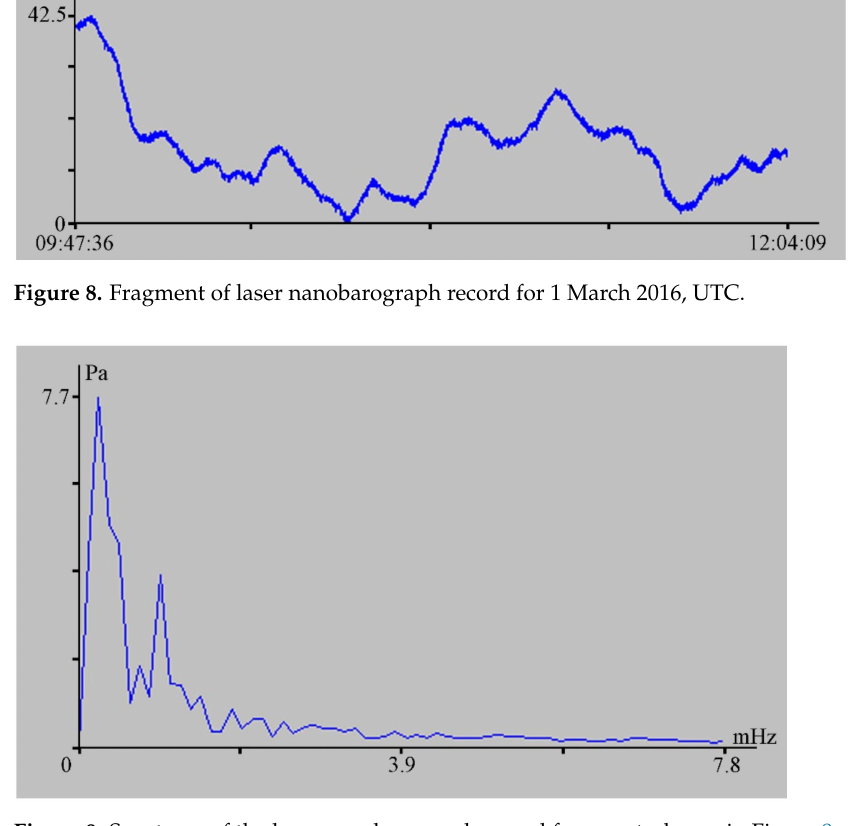
Figure 9. Spectrum of the laser nanobarograph record fragment, shown in Figure